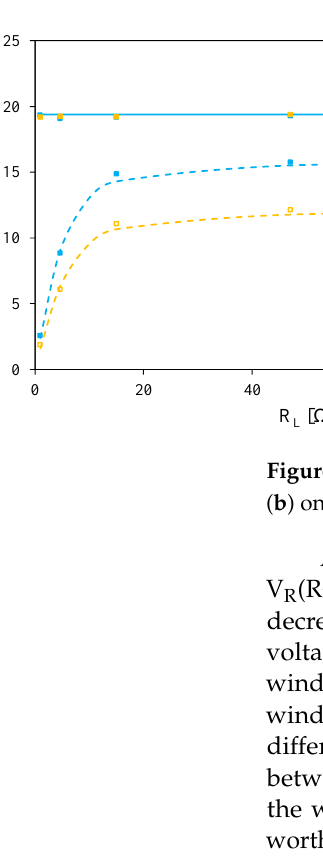
Figure 10. Dependence of mutual thermal resistance between the coils on the distance between these coils.